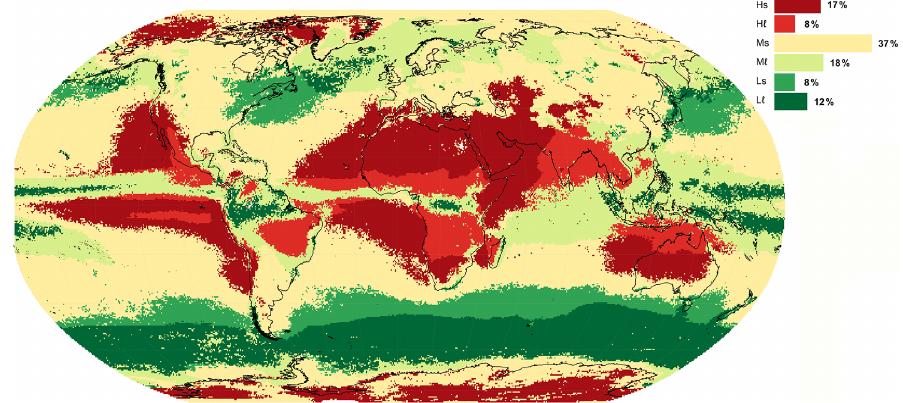
Figure 3. Climatic classification of meteorological droughts around the world: regions with low (L), medium (M), or high (H) values of the DSS n index, alternating with longer ( (cid:96) ) or shorter (s) wet